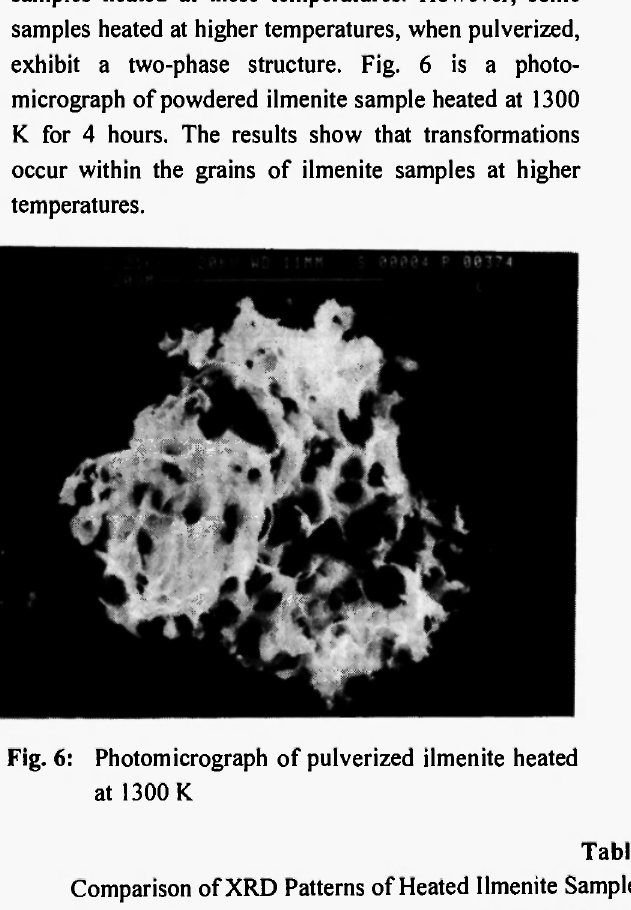
Comparison of XRD Patterns of Heated Ilmenite Samples with the Standard Titanium and Iron Compounds Period of Soaking = 4